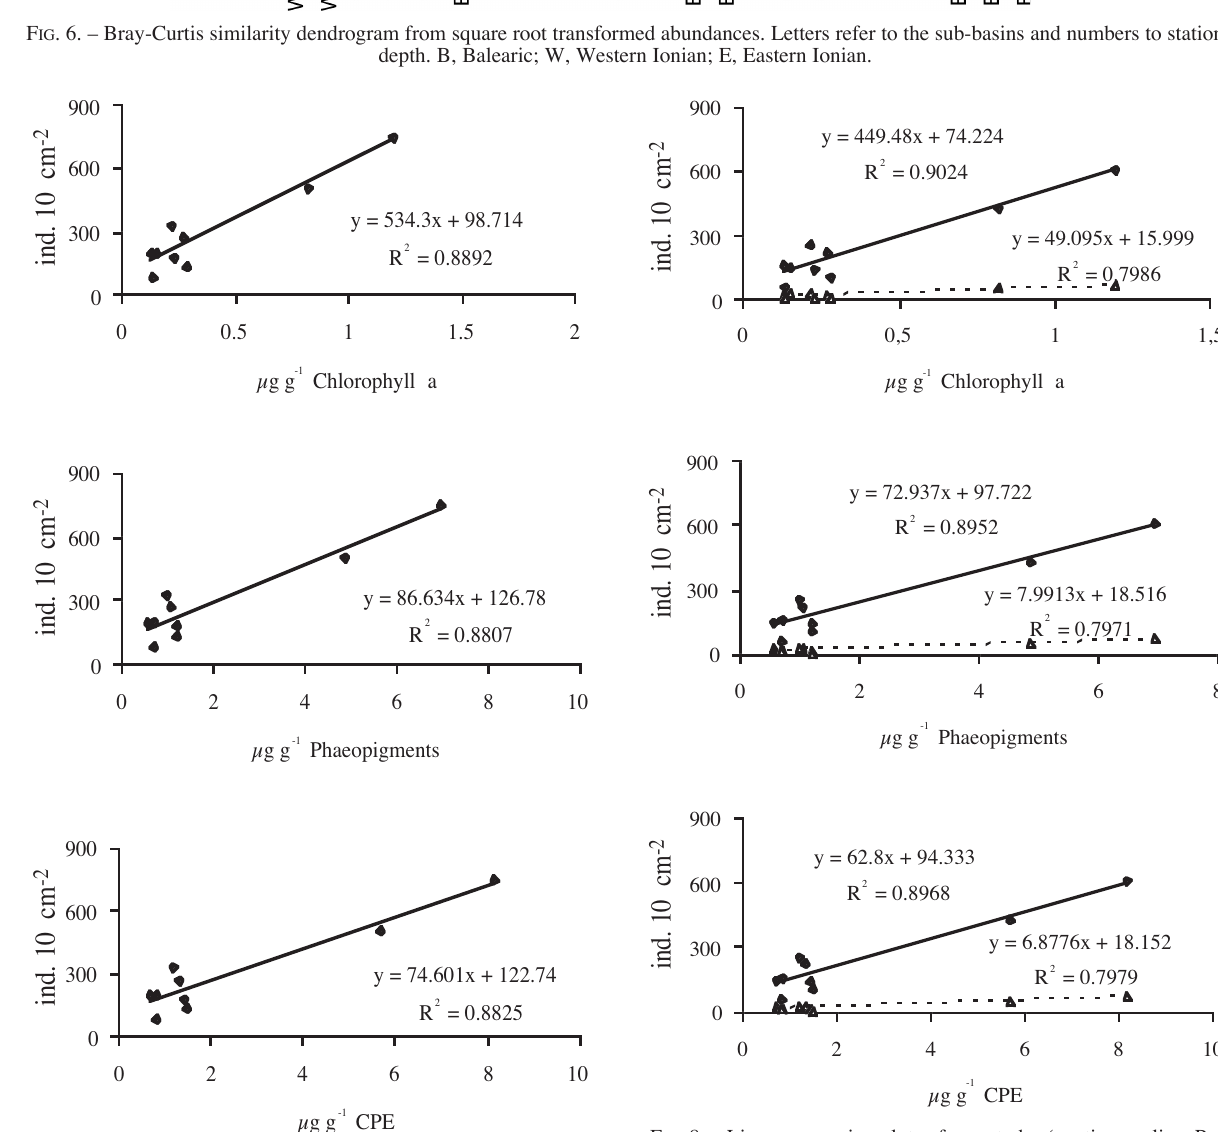
F IG . 8. – Linear regression plots of nematodes (continuous line, P < 0.001) and foraminiferan abundance (dashed line, P < 0.01) in the upper 5 cm of the sediment versus Chlorophyll a , Phaeopigments and